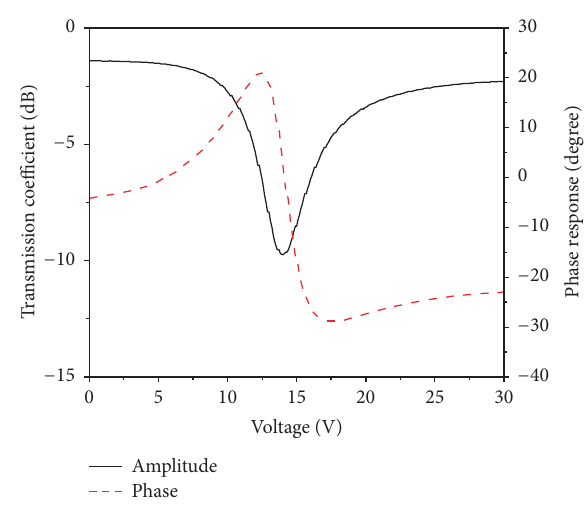
Figure 6: Measured results of transmission coefficient and phase response under different bias voltages at 2.4 GHz.